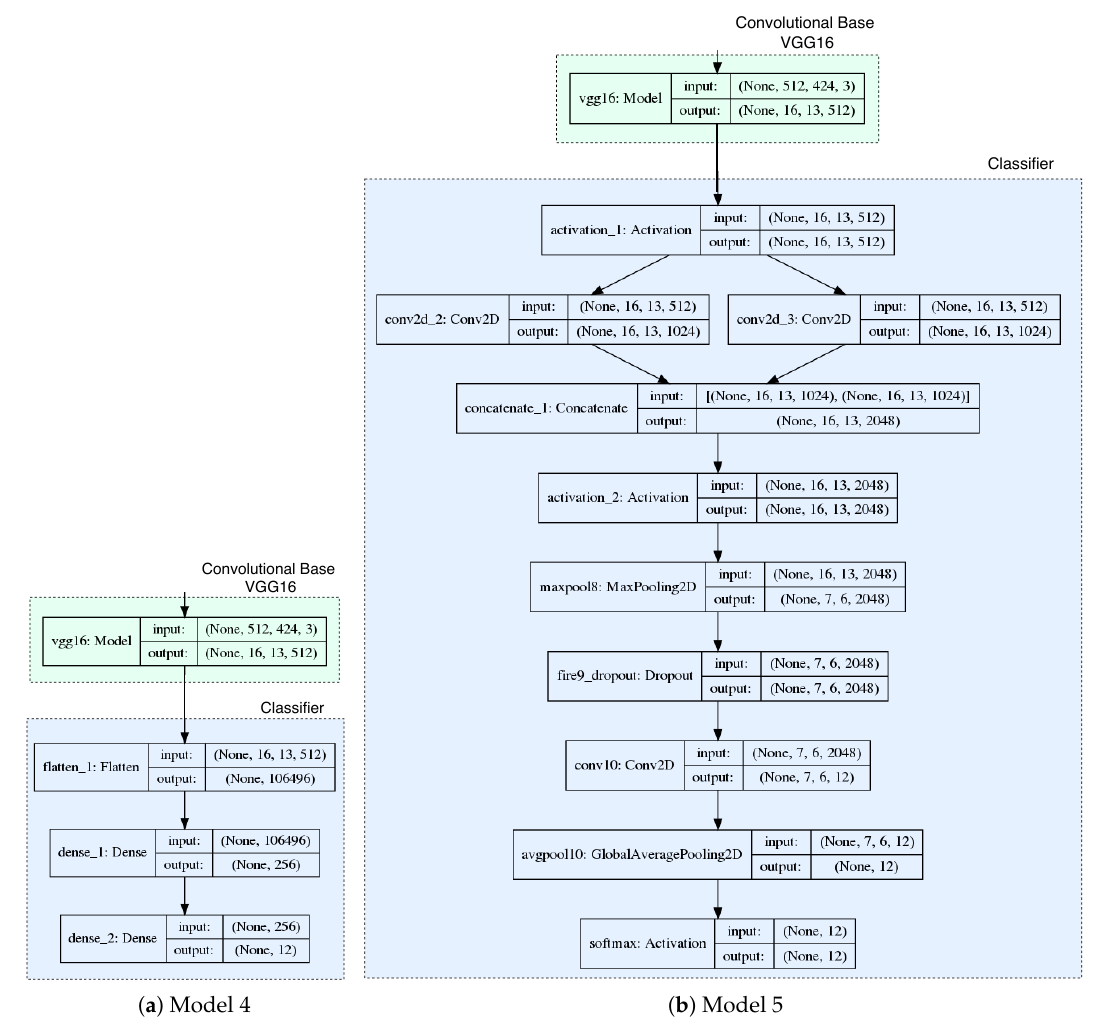
Figure 4. Transfer Learning: Architecture of the models taken into account. Keras support to graph models [29] was